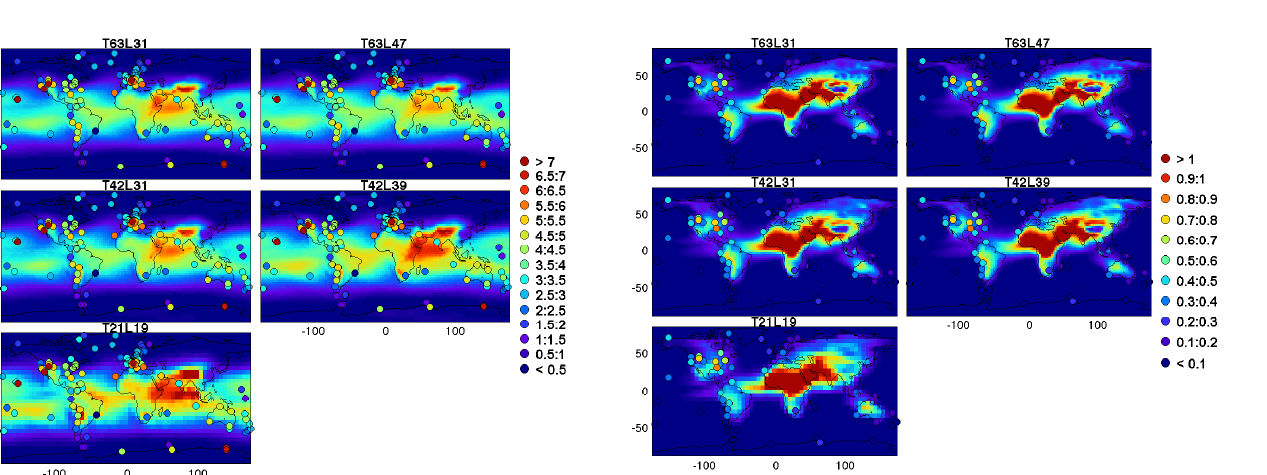
Fig. 5. 1998–2002 mean deposition flux of 210 Pb atoms (1000 m − 2 s − 1 ) with different model resolutions. The dots show the location and observed deposition flux of the measurement stations (refer- ences given in the text).